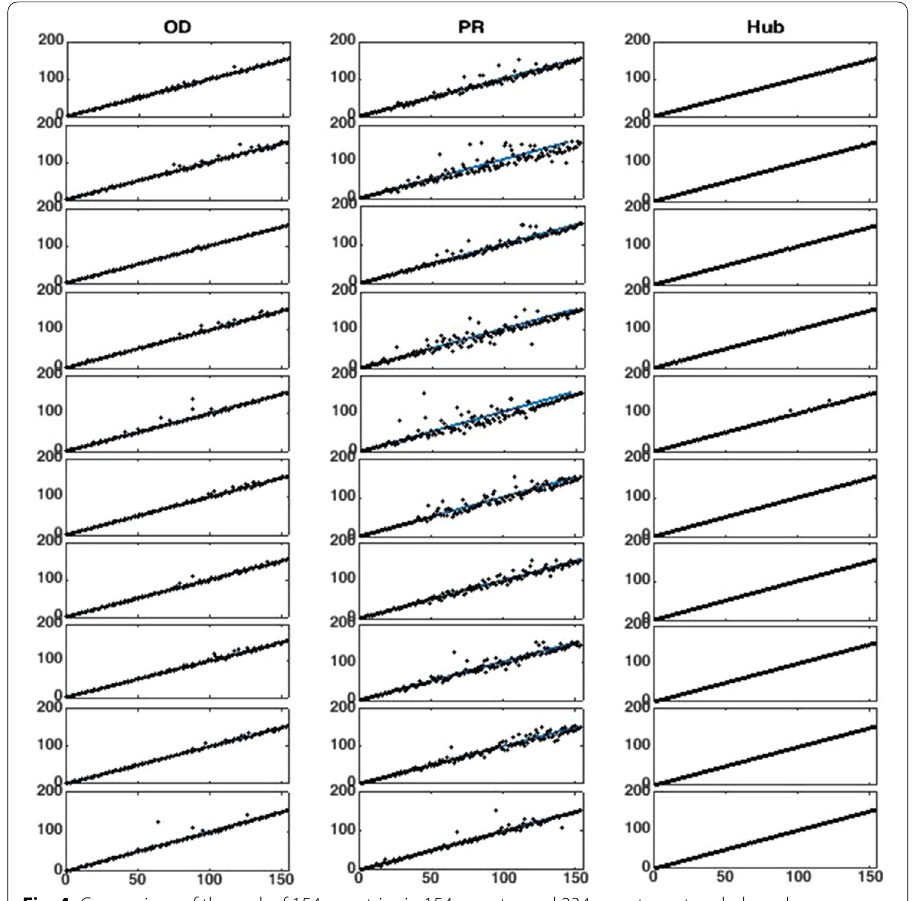
Fig. 4 Comparison of the rank of 154 countries in 154-country and 234-country networks based on out-degree, PageRank, and hubness in 10 commodity groups and export sector. Each row represents a commodity group. The vertical axis shows the 154 common countries in the 234-country network. The horizontal axis shows 154 countries in the 154-country network. The blue plot represents the fitted line to the rank of 154 common